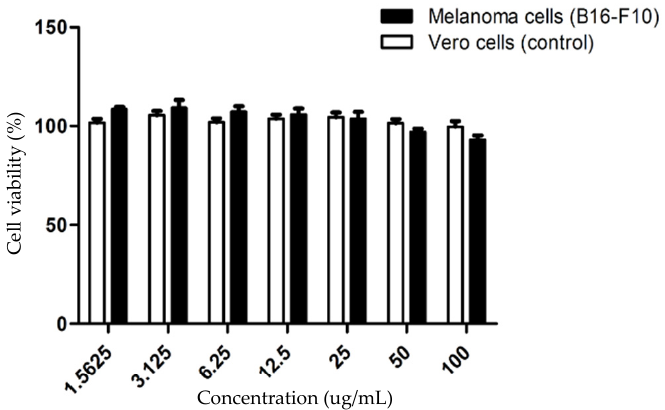
Figure 3. The concentration-dependent effect of the octapeptide on melanoma and Vero cell viability using the MTT assay. Melanoma cells as ( (cid:4) ) and Vero cells as ( (cid:3) ) were incubated with 1.5625–100 µ g/mL octapeptide for 48 h. Data are shown as mean ± SD from triplicate results.